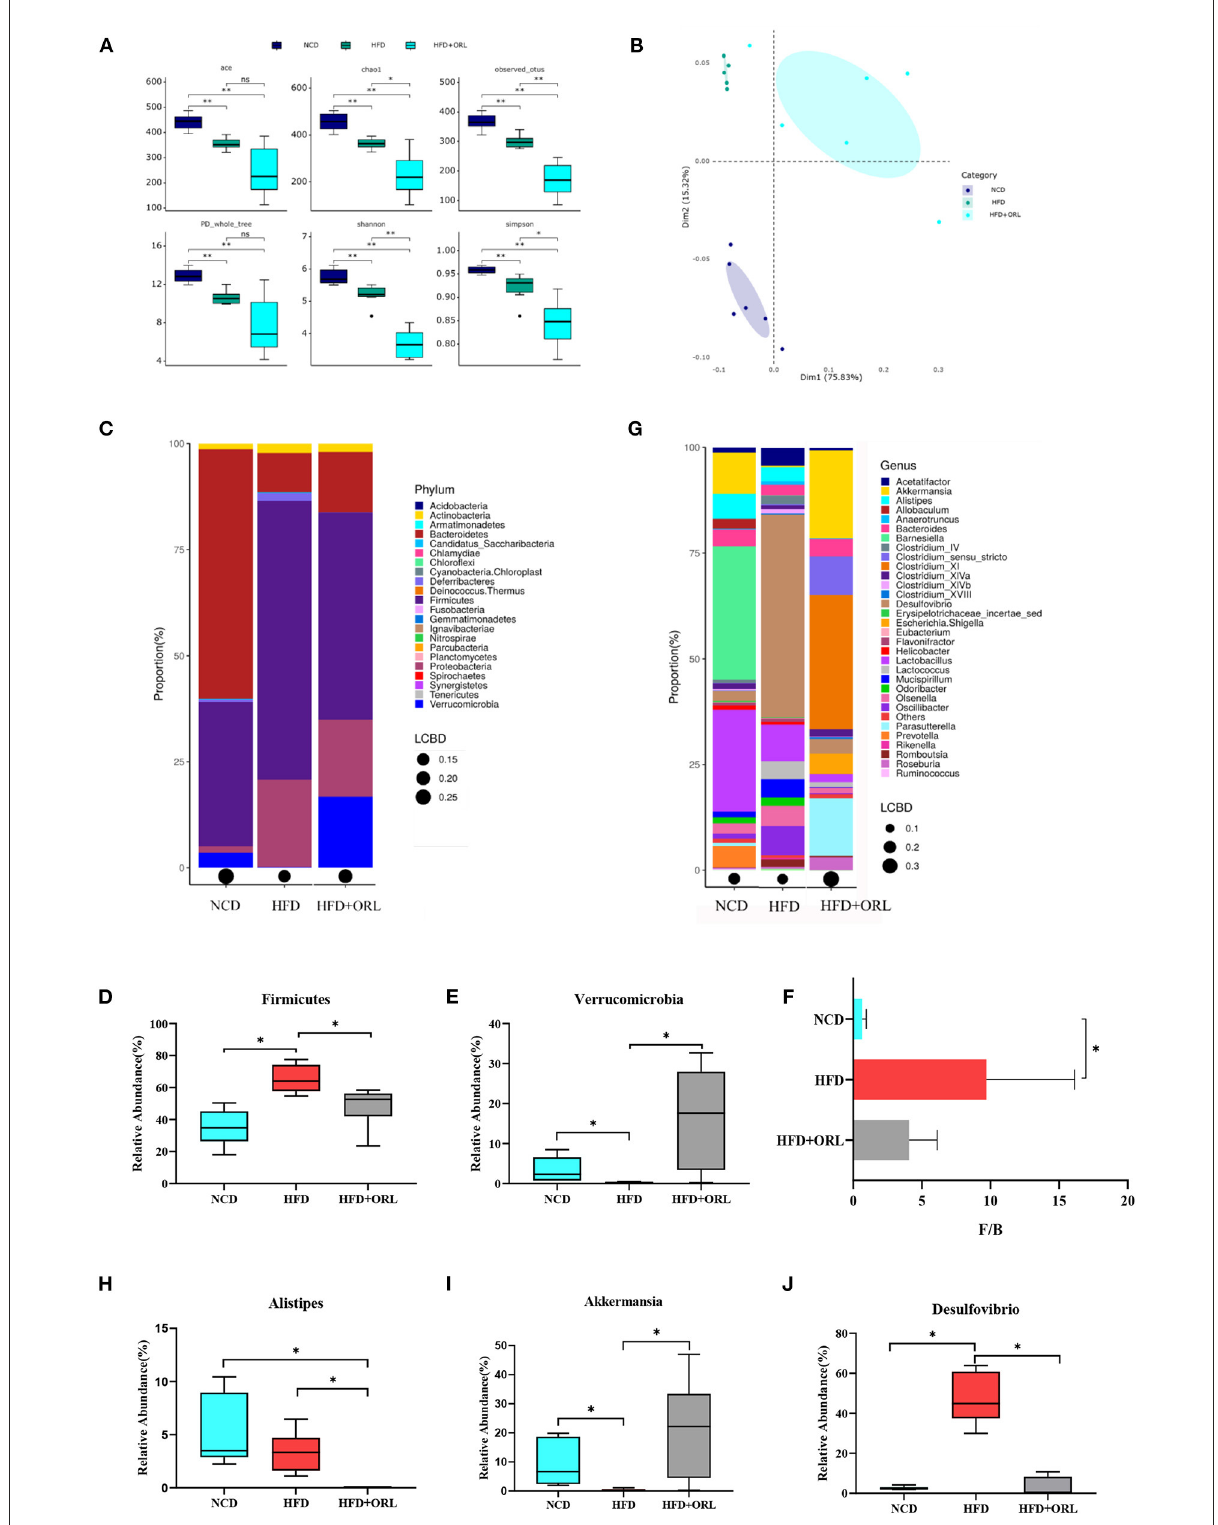
FIGURE5 Alterations in gut microbiota before and after orlistat intervention. (A) The α -diversity of fecal microbiota in mice. (B) Beta-diversity was visualized by PCoA analysis. (C) Bar plot of gut microbiota composition at the phylum level. (D,E) The relative abundance of Firmicutes and Verrucomicrobia was significantly changed after intervention by Metastas analysis. (F) Firmicutes -to- Bacteroidetes ratio ( F / B ) of mice.